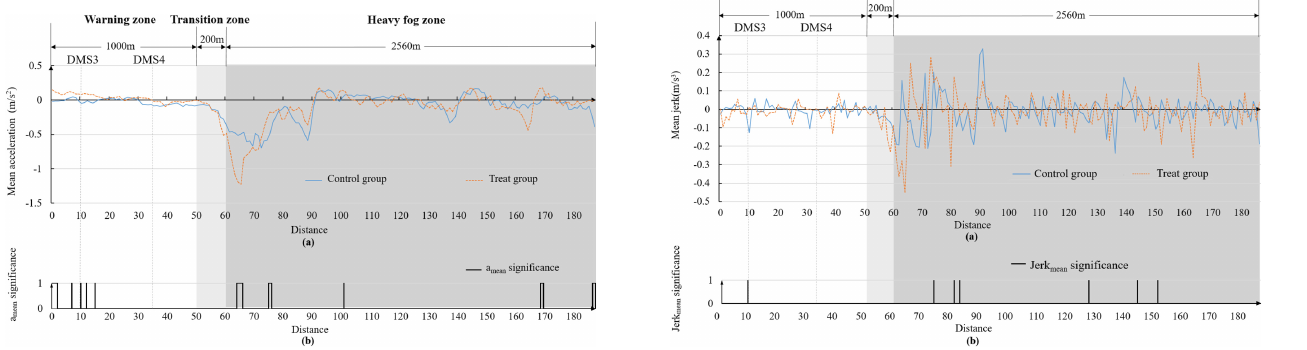
Figure 7 Effect of the fog warning system on acceleration